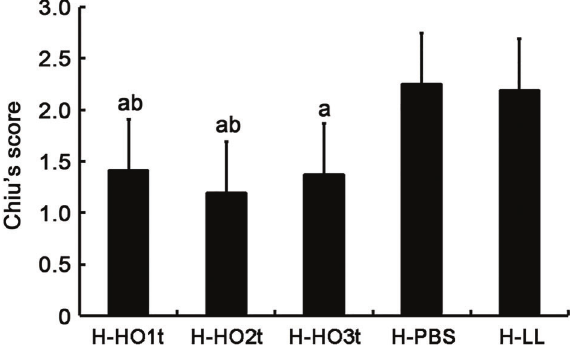
Figure 2. Myeloperoxidase (MPO) activity in normal (N) groups and hemorrhagic shock (H) groups treated with Lactococcus lactis expressing heme oxygenase-1 once (HO1t), twice (HO2t) or thrice (HO3t) or with phosphate-buffered saline (PBS) and L. lactis (LL). a P o 0.05, compared with H-PBS and H-LL; b P o 0.05, compared with H-HO3t; c P o 0.05, compared with N; d P o 0.05, compared with N group (ANOVA). Data are reported as means ± SD.